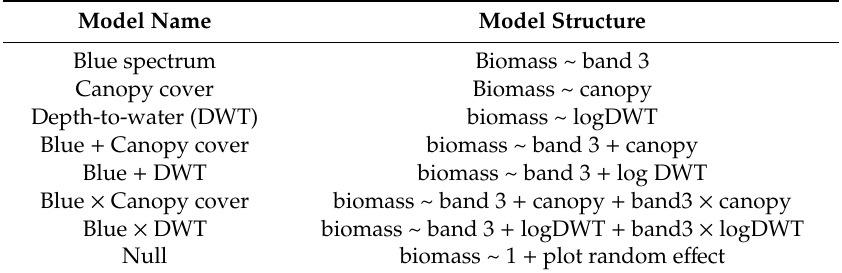
Table 2. Name and structure of candidate models used to predict lichen biomass. Covariates within the same model have a Pearson’s correlation coe ffi cient > | 0.7 | . DWT refers to the depth to water table, Blue refers to blue spectral data, and canopy refers to canopy